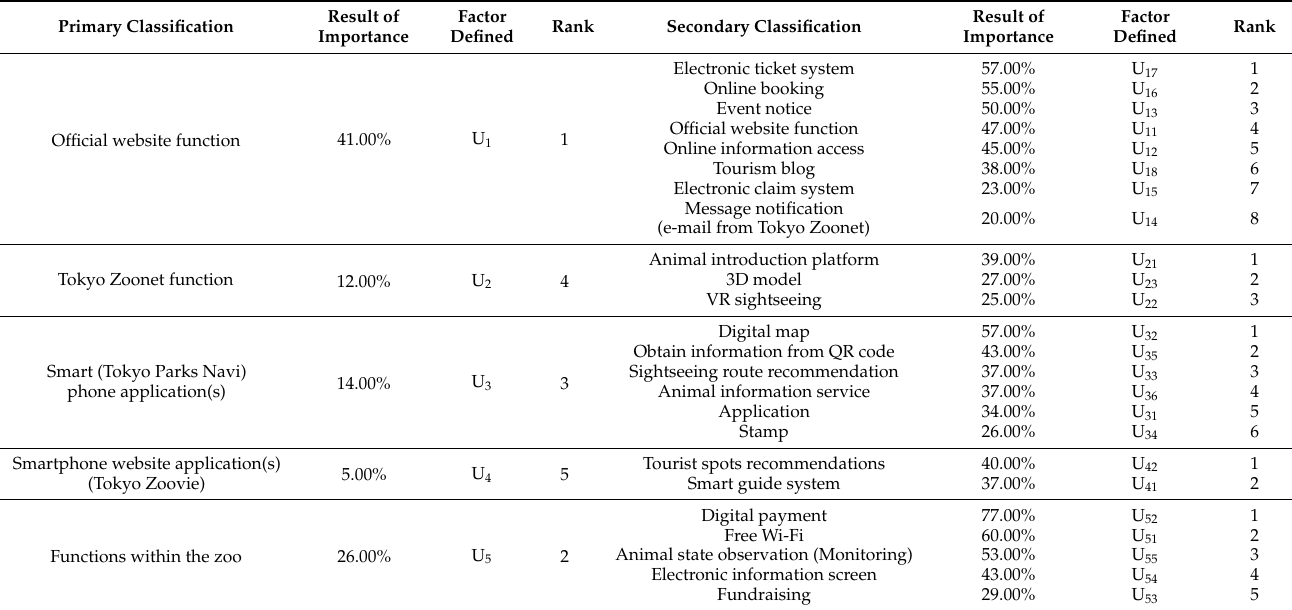
Table 3. The importance ranking of the questionnaire.